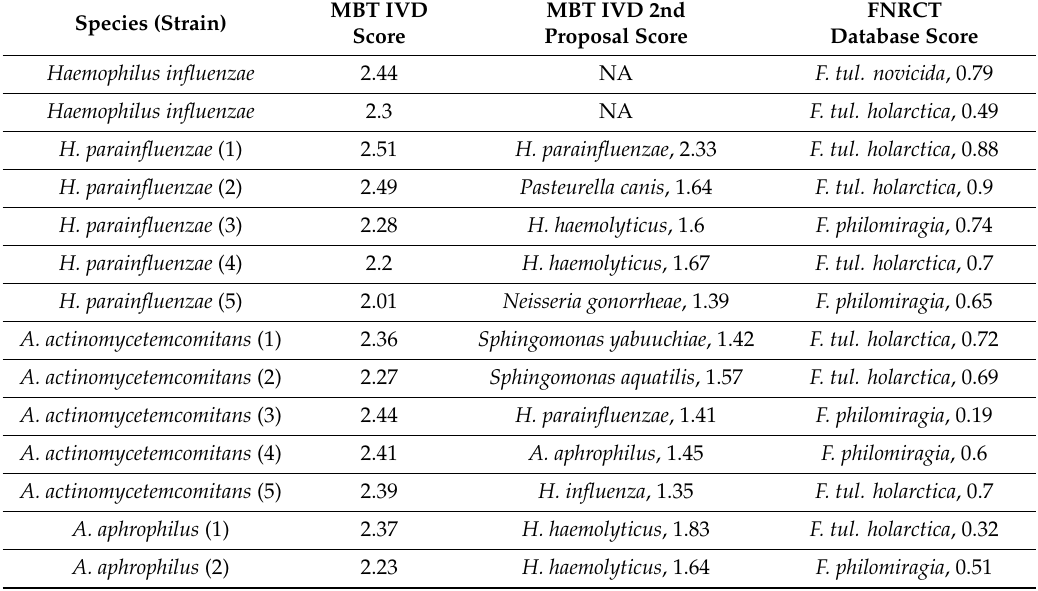
Table 2. Identification scores obtained with Haemophilus , Aggregatibacter , Capnocytophaga , Eikenella , and Kingella (HACEK group of species) and Brucella melitensis using the MBT IVD or FNRCT